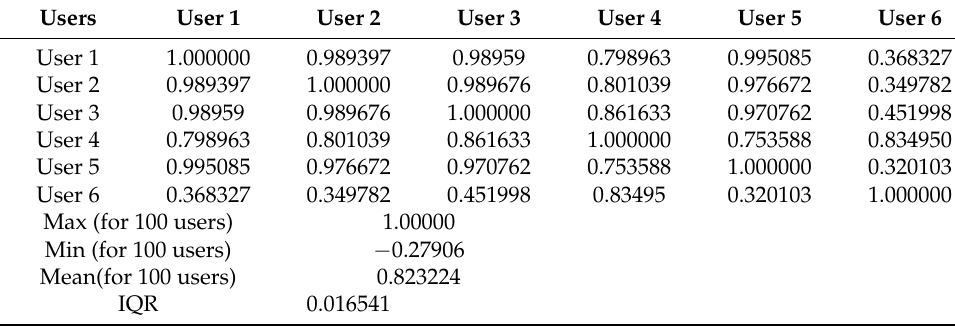
Table 6. Similarity Matrix based on